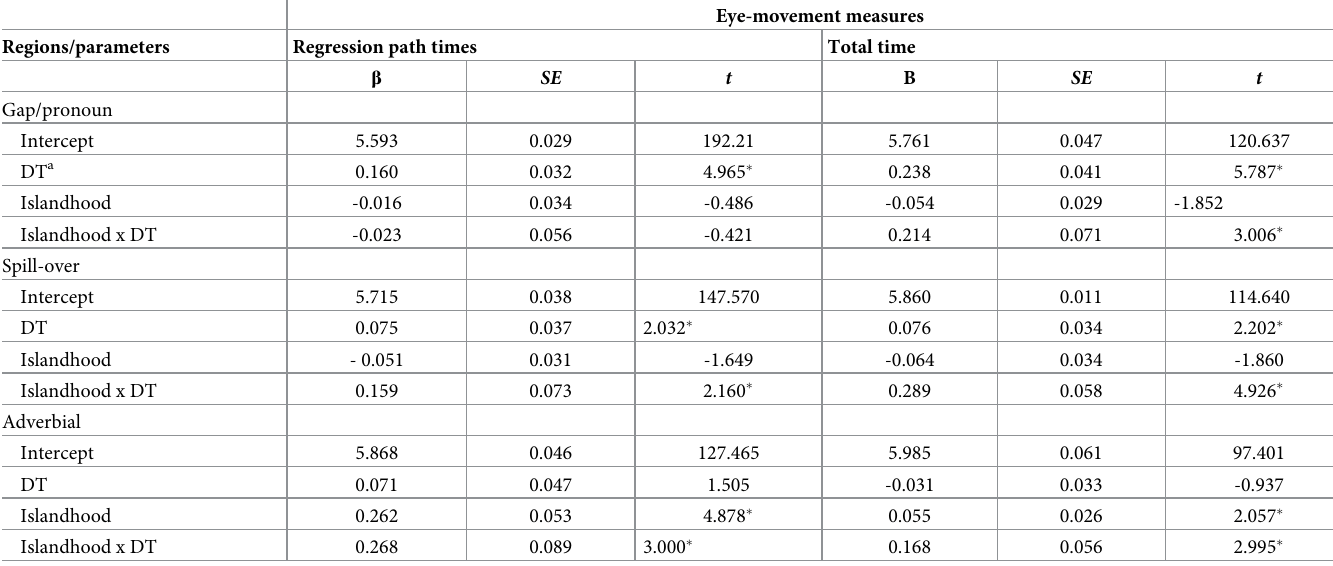
Table 3. Results of mixed-effects analysis for the eye-movement measures for Experiment